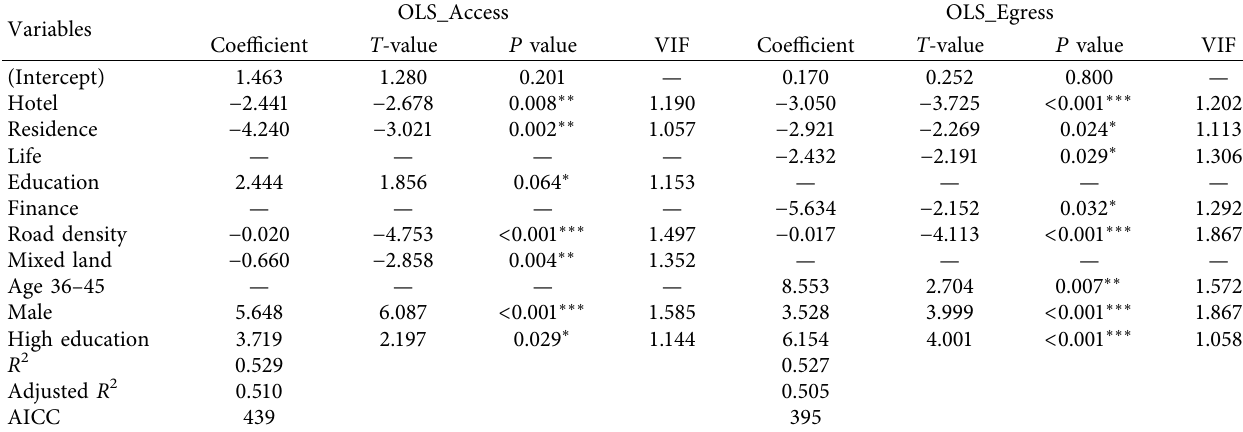
Table 6: Results of the ordinary least squares regression